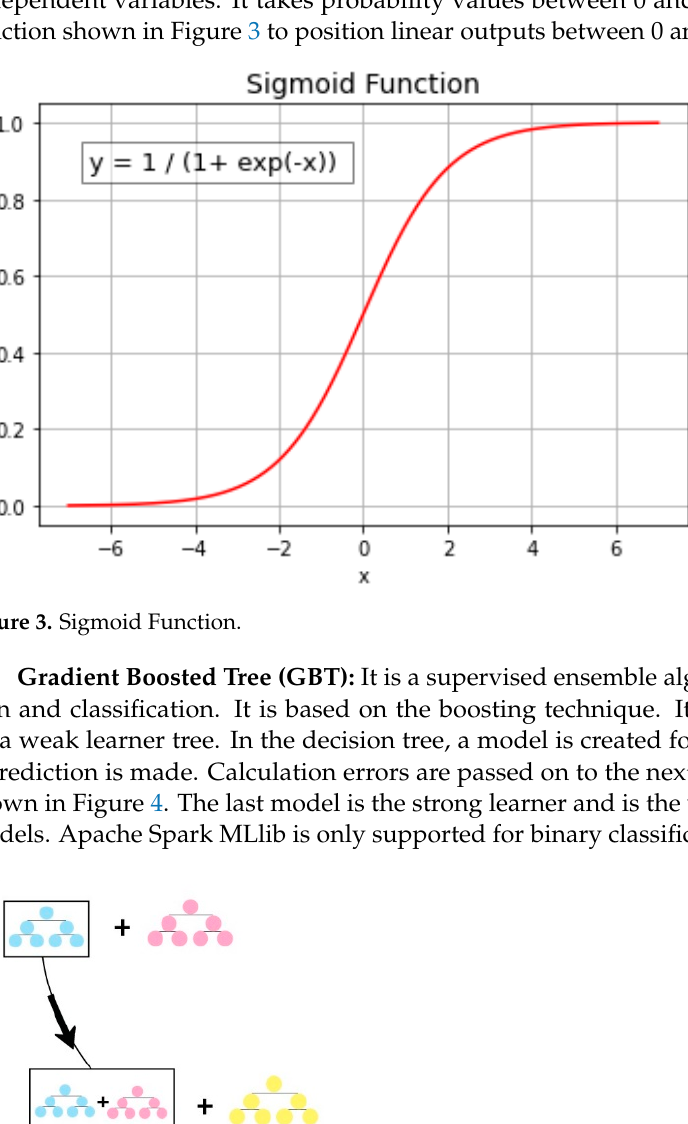
Figure 4. Gradient Boosted Tree Iterations.